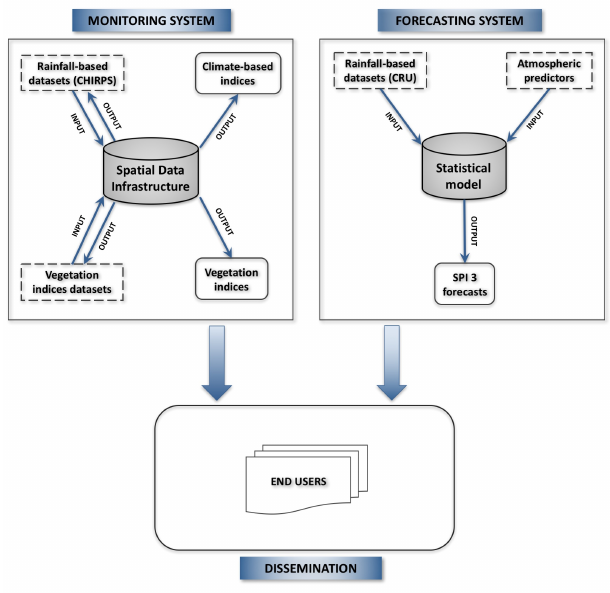
Figure 2. Workflow model of the drought-monitoring and forecasting operational